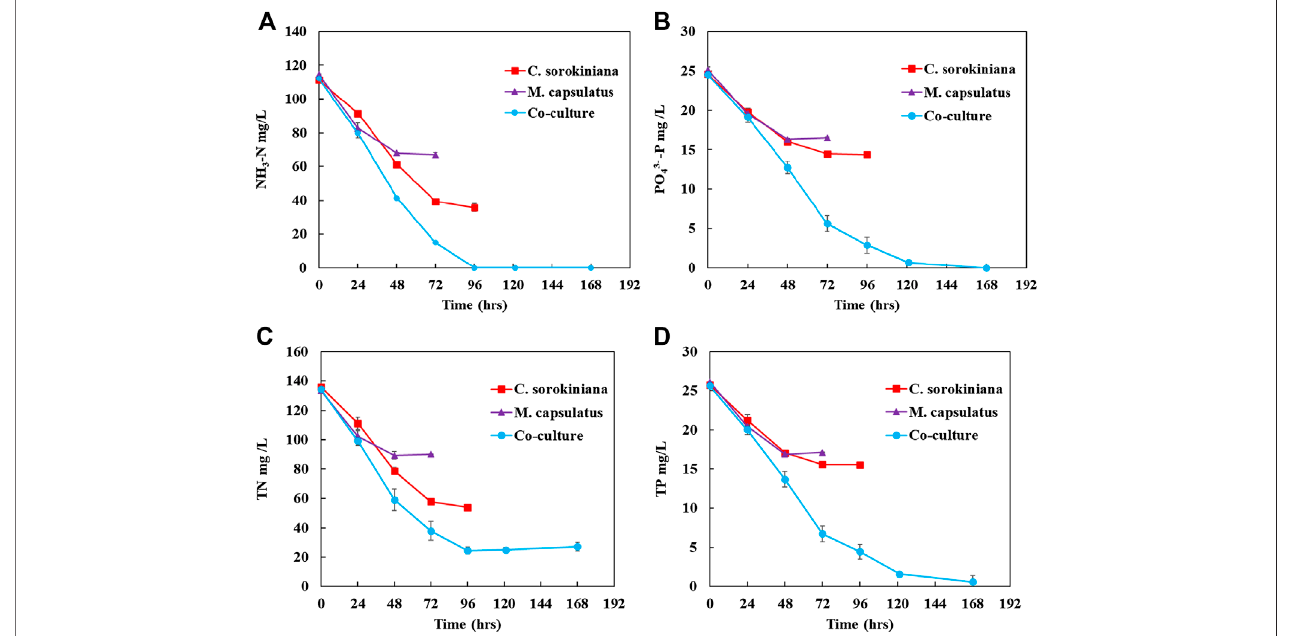
FIGURE 11 | Inorganic nutrient recovery by the sequential single cultures and by the coculture for (A) NH 3 -N, (B) PO 43 − − P, (C) total nitrogen, and (D) total phosphorus. The coculture exhibits enhanced nutrient recovery compared to the sequential single cultures.